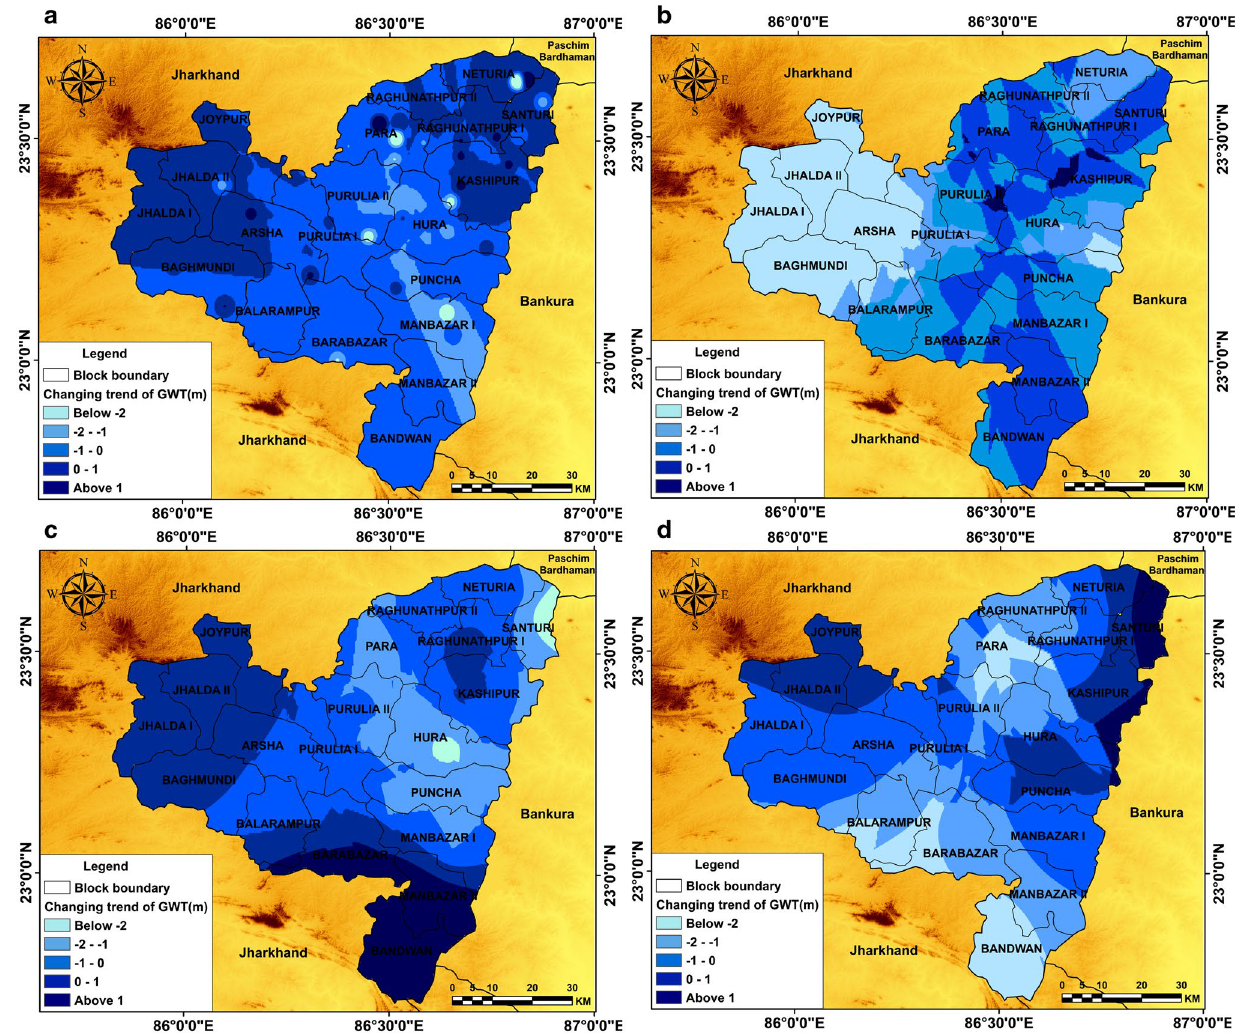
Fig. 3 Changes of groundwater height scenario at Purulia district of different years in pre monsoon season, a 1996–2001, b 2001–2006, c